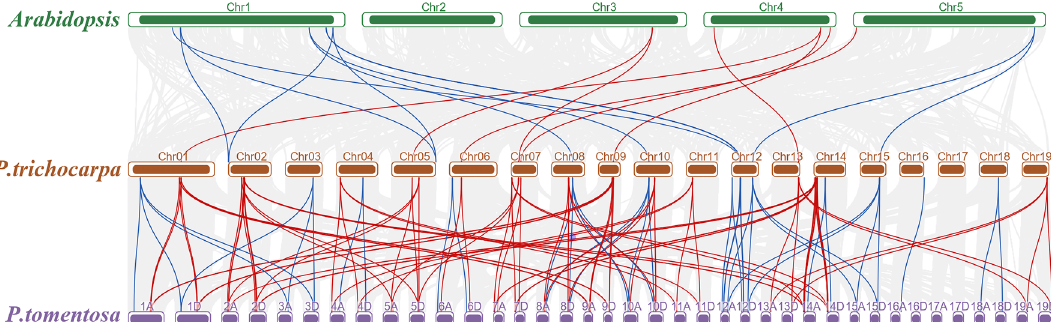
Figure 4. Synteny of CYCD and CDK genes in Arabidopsis , P. trichocarpa and P. tomentosa . Red and blue lines represent duplicated CYCD and CDK gene pairs,